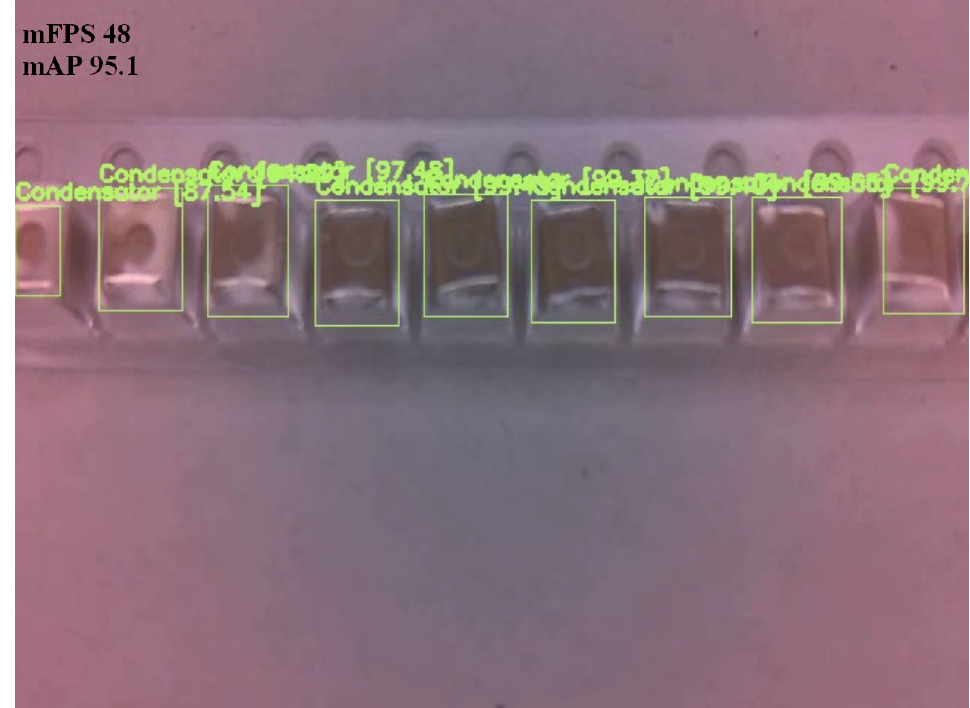
Figure 8. Frame of electronics components detection input using YOLOv4